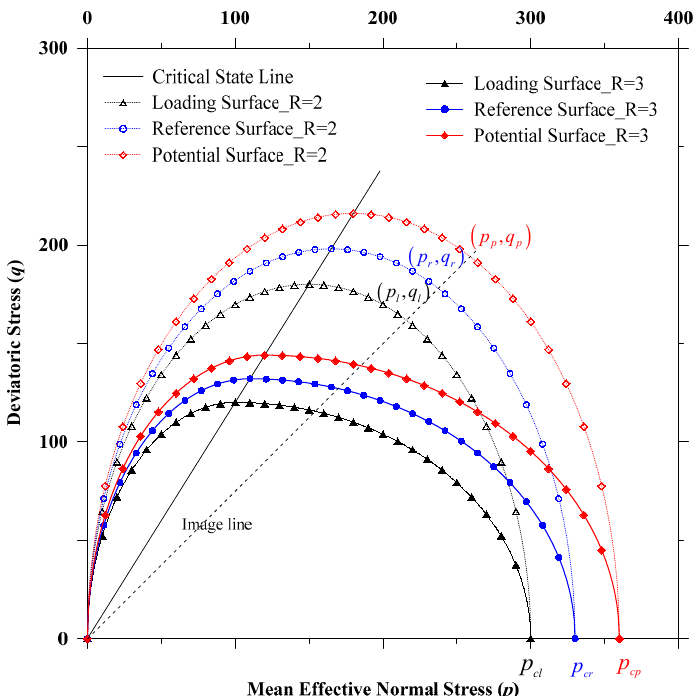
Figure 2. In the p - q plane, schematic representation of the potential surface, the reference surface and the loading surface and the surface shape parameter effect.